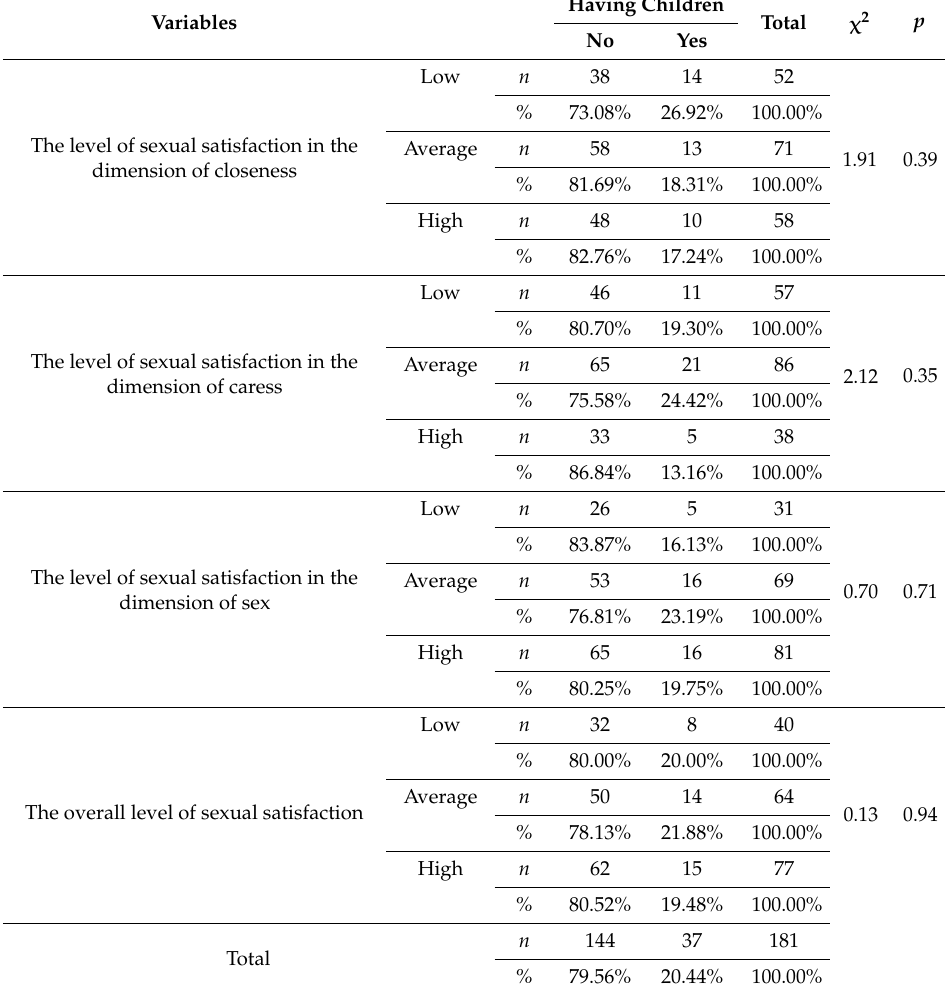
Table 7. Relationship between the level of sexual satisfaction and having